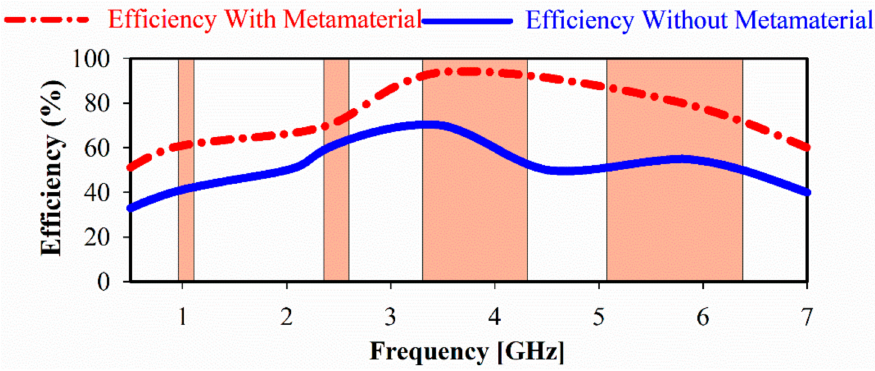
Figure 15. The proposed CPW antenna e ffi ciency with and without